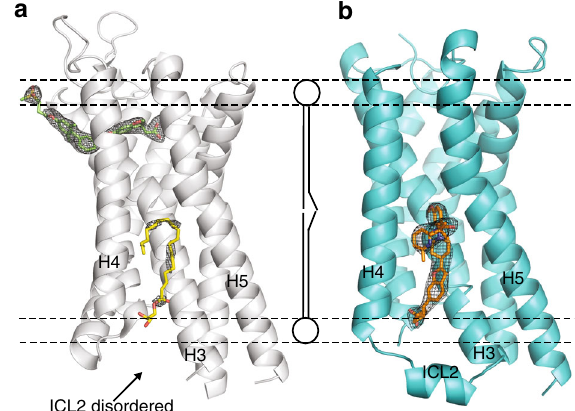
Fig. 4 X-ray crystal structures of human GPR40-TAK-875 (PDB: 4PHU) and GPR40-compound 1 complexes. a GPR40 (gray ribbon) in complex with TAK-875 (green stick) in site A1. Monoolein is modeled in site A2 (yellow stick) in 4PHU. b , GPR40 (cyan ribbon) in complex with compound 1 (orange stick) in site A2. Transmembrane helices H3, H4, H5 and intracellular loop 2 (ICL2) are labeled. Phospholipids are rendered as balls and lines, illustrating the transmembrane region of the receptor. The F o -F c omit maps of TAK-875, monoolein, and compound 1 were calculated in their absence and are shown as black mesh and contoured at 3.0 σ . Figures were prepared using PyMOL (Schrödinger, New York). Stereo image of b is provided in Supplementary Fig.